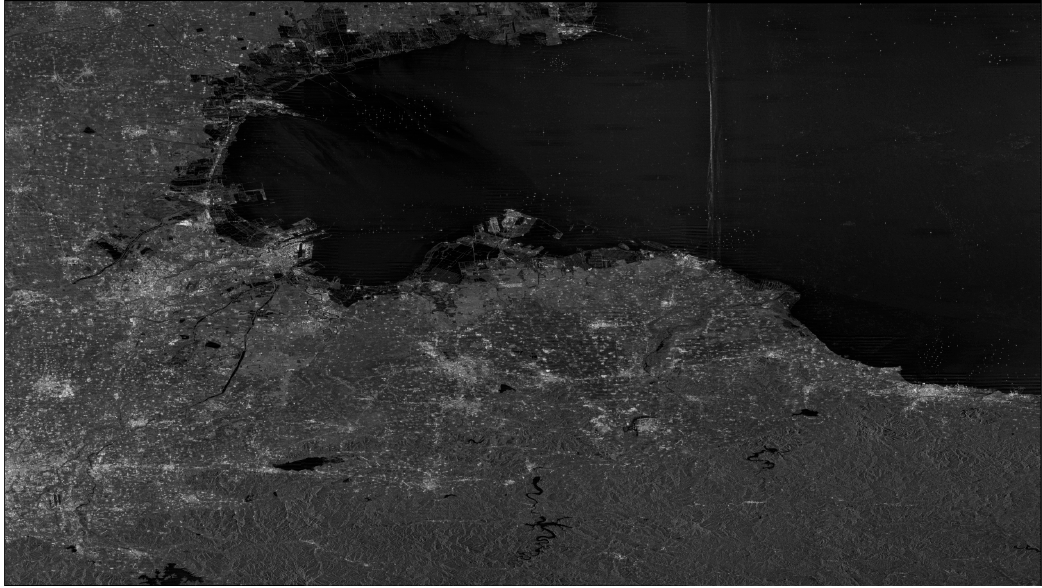
Figure 19. ScanSAR image of GF-3 in Bohai bay area.